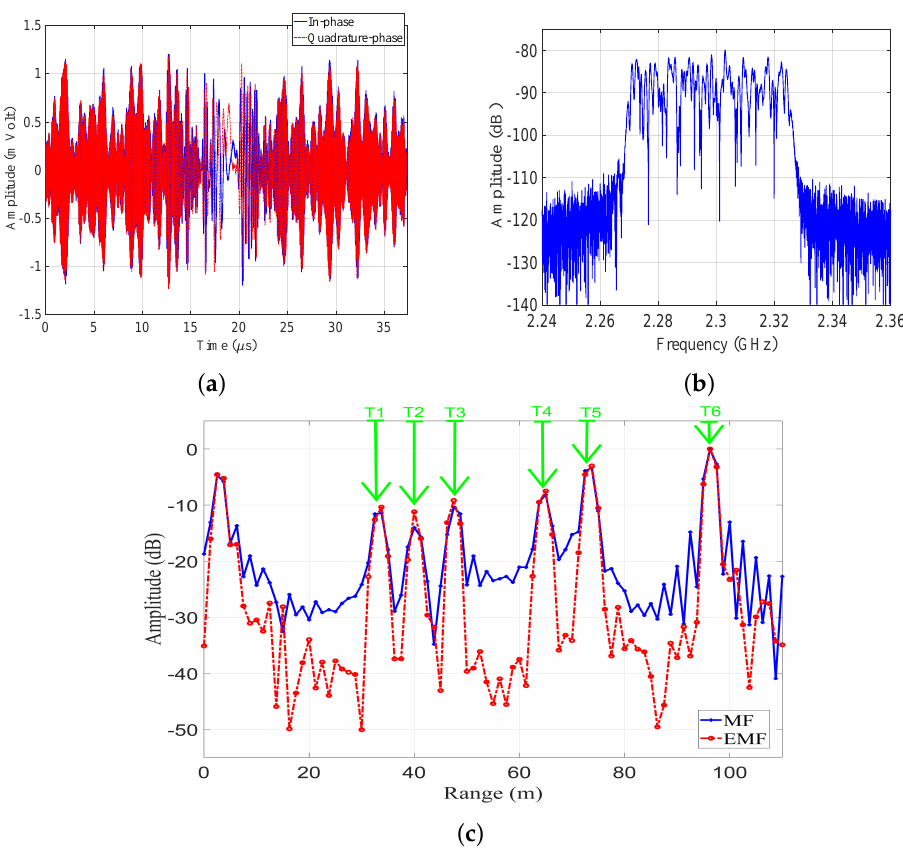
Figure 23. The open field experiment’s results: ( a ) Received signal in the time domain. ( b ) Frequency spectrum of the received LFM signal. ( c ) Amplitude responses of MF and proposed